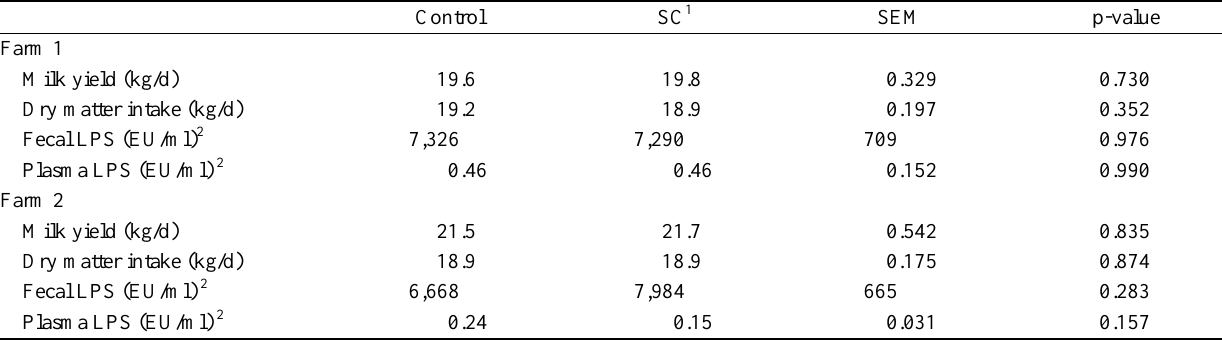
Table 2. Pre-trial (d 0) milk yield, dry matter intake and fecal and plasma LPS